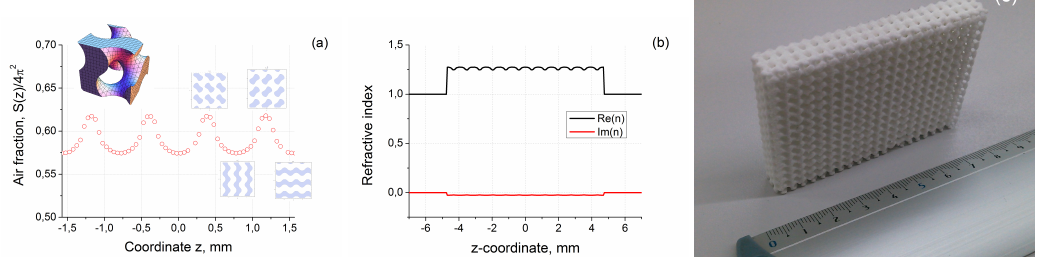
Figure 3. ( a ) Relative air fraction distribution in gyroid along the z-axis (Inset: single unit cell of the structure and characteristic cross-sections of periodic material); ( b ) calculated distribution of refractive index about z-axis; ( c ) printed sample.